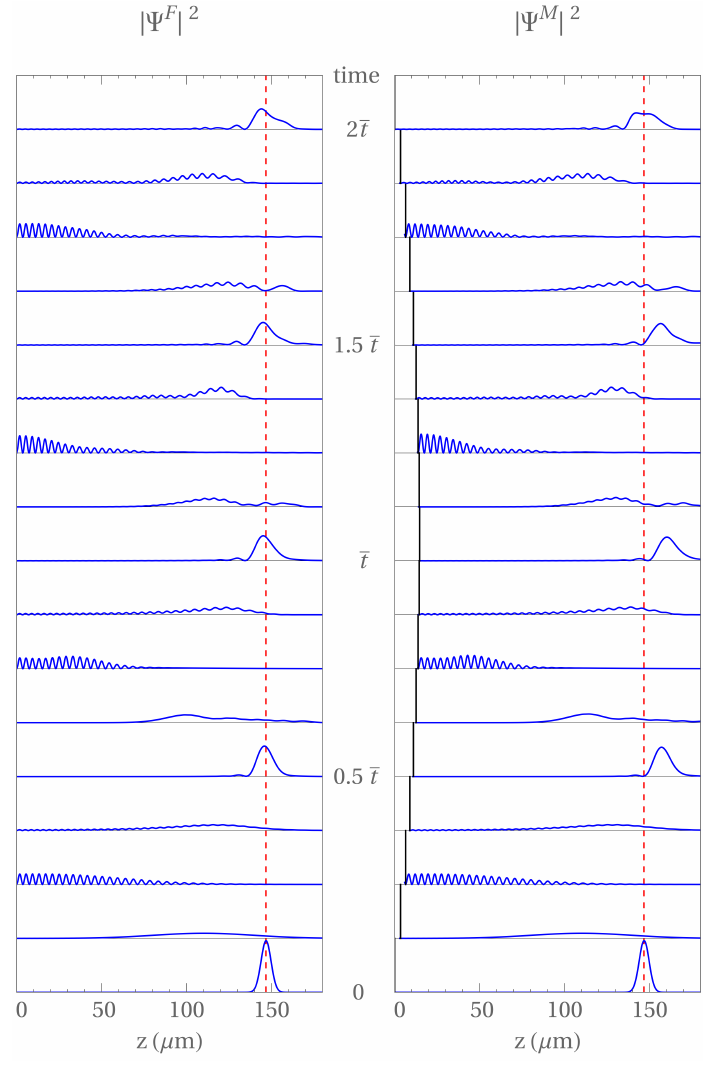
Figure 3. Evolution of an initial Gaussian wave packet released at rest from a height z 0 = 25 l g , and bouncing over a fixed mirror ( left panel ) or over a moving mirror ( right panel ). The initial Gaussian is at the bottom ( t increases from bottom to top); the red dotted line shows the average position while the parabolic black curve on the right panel indicates the mirror’s position (the parameters of the mirror are in gravitational units a = − 0.00625, b = 0.25, and c = 0). The mirror returns to its initial position at t = 2¯ t . We have rescaled the gravitational units so that the numbers on the axes correspond to a neutron falling in the gravitational field of the Earth, leading to z 0 = 146.7 µ m, ¯ t = 21.88 ms and L ( ¯ t ) = 14.67 µ